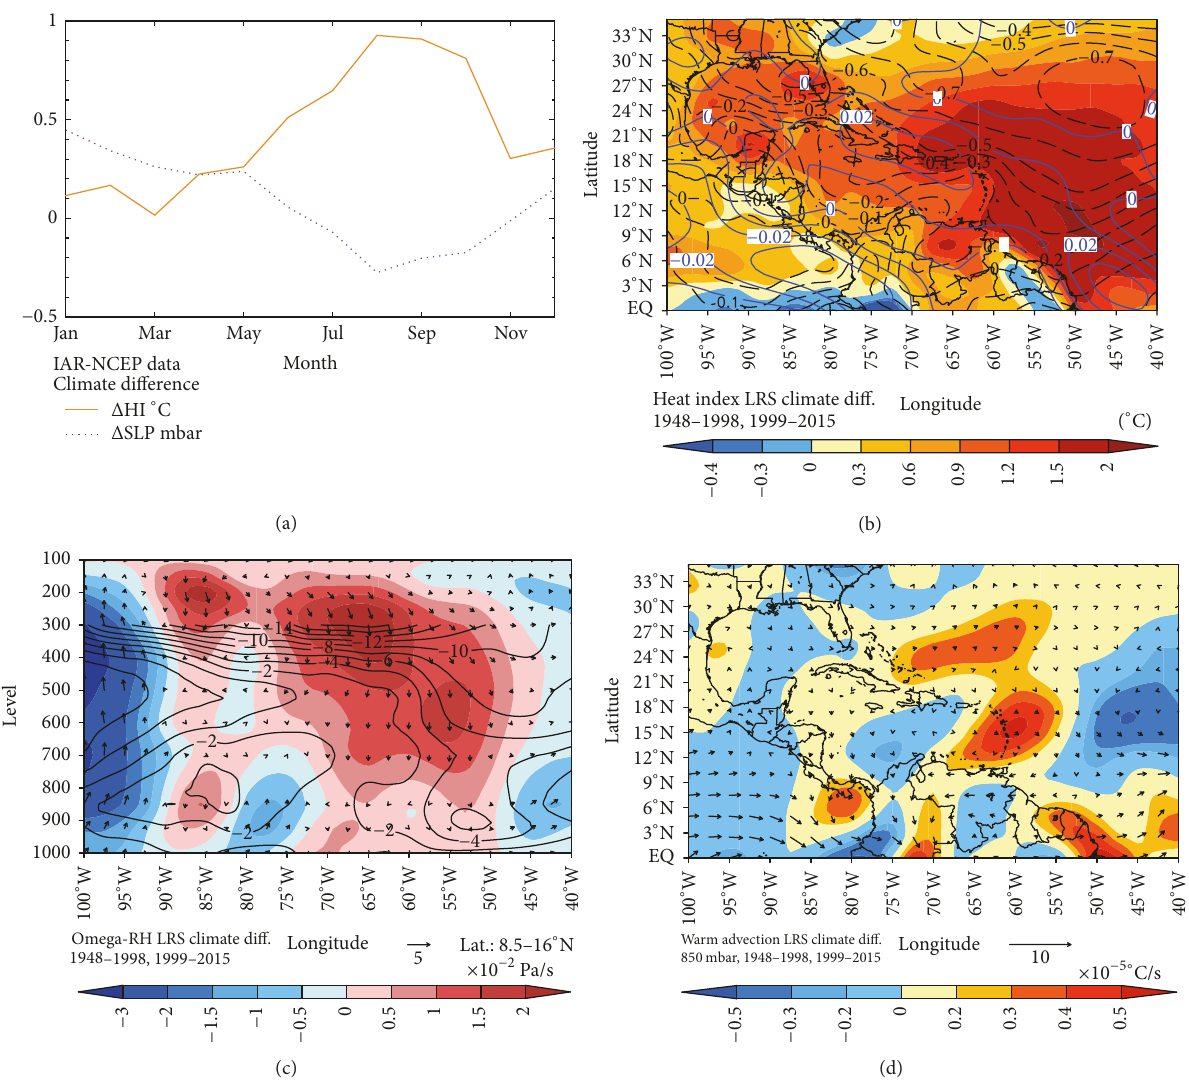
Figure 4: (a) Climate difference between 1999–2015 and 1948–1998 for HI and SLP. (b) LRS heat index change in ∘ C (color shades), SLP change (dotted black contour line), and vertical velocity change in Pa/s (blue contour line). (c) LRS vertical velocity change in color shades ( × 10 −2 Pa/s), relative humidity in % (black contour line), and wind vector. (d) LRS warm/cold advection change in color shades ( × 10 −5∘ C/s) and wind vector at 850